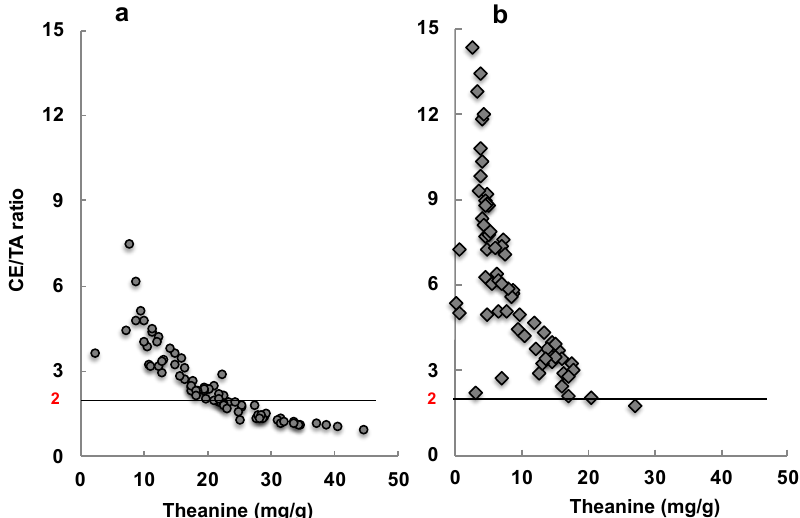
Figure 10. The amount of theanine, and the molar ratio of caffeine and EGCG to theanine and arginine, in 76 samples of Matcha marketed in Japan ( a ) and 67 samples of Matcha marketed outside of Japan ( b ).